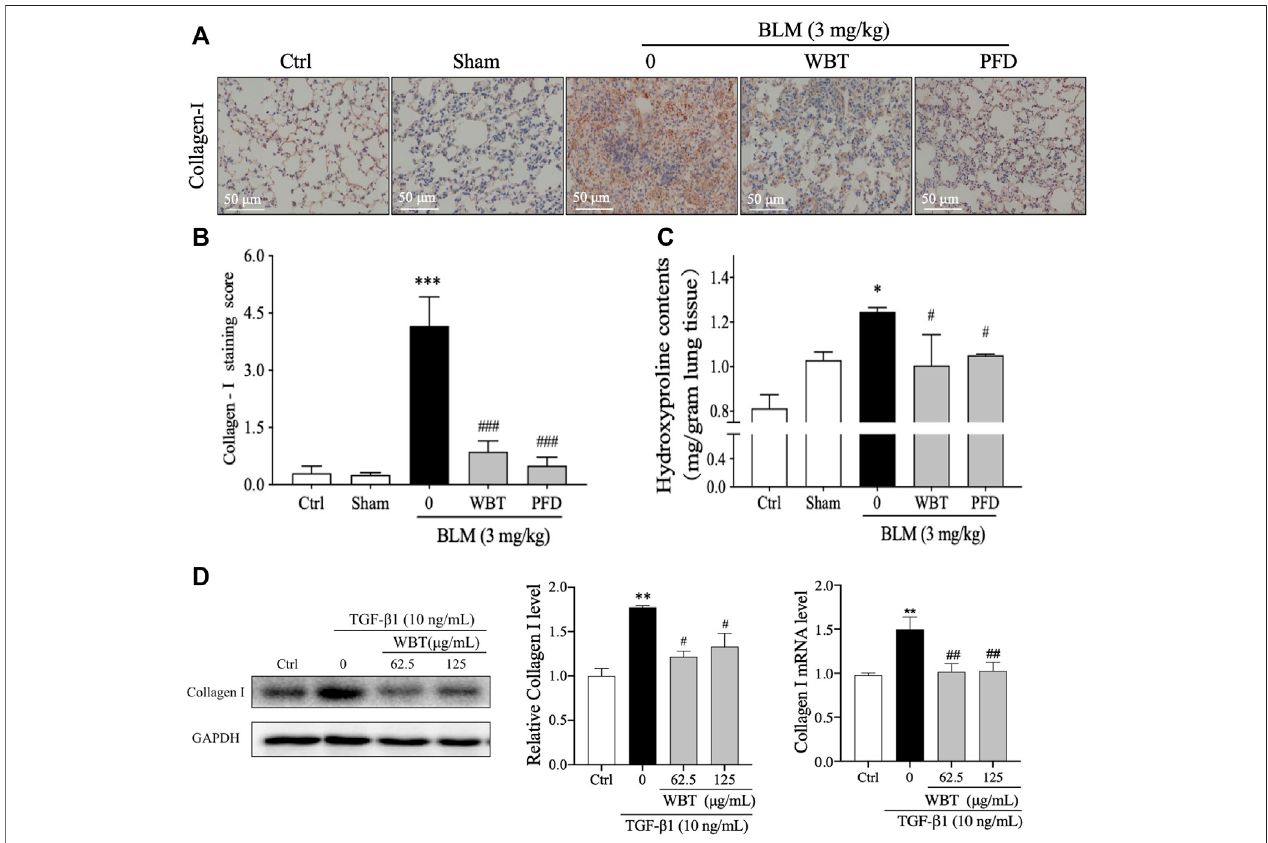
FIGURE 7 | WBT formula inhibited BLM-induced collagen deposition in the mouse and TC-1 cell model of lung fi brosis. (A) The level of collagen I was detected by immunohistochemical staining in the mouse lung from different groups. Scale bar (cid:1) 50 μ m. (B) The relative collagen I level from (A) was quanti fi ed (n (cid:1) 5); *** p < 0.001, comparedtotheshamgroup;### p < 0.001,comparedtotheBLMgroup. (C) Thecontentofhydroxyprolineinthelungtissuesfromdifferentgroupswasdeterminedby a commercial measurement kit. (D) After incubation with TGF- β 1 and/or WBT for 48 h, qPCR and Western blot analysis were performed. The relative levels of collagen I in TC-1 cells were calculated and normalized to GAPDH. Data are from three independent experiments. * p < 0.05, ** p < 0.01, and *** p < 0.001, compared to the sham group; # p < 0.05, ## p < 0.05, and ### p < 0.001, compared to the BLM or TGF- β 1 group. BLM, bleomycin; WBT, Wenfei Buqi Tongluo formula; PFD, pirfenidone (TGF- β 1, 10